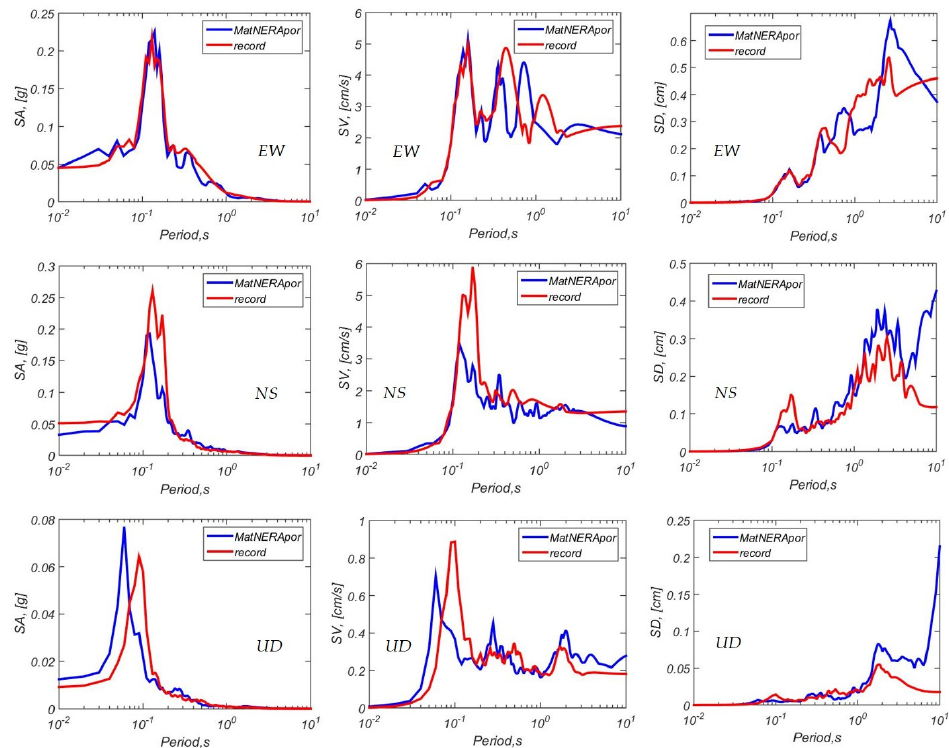
Figure 8. Degradation curves of shear modulus G/G max ( γ ) ( a ), constrained moduli above water table M/M max ( γ ) ( b ) and under water table M*/M* max ( γ ) ( c ) and corresponding damping ratio curves D ( γ ) ( c ) used for modeling the responses for TCGH15 and KSRH10 Kik-net sites.